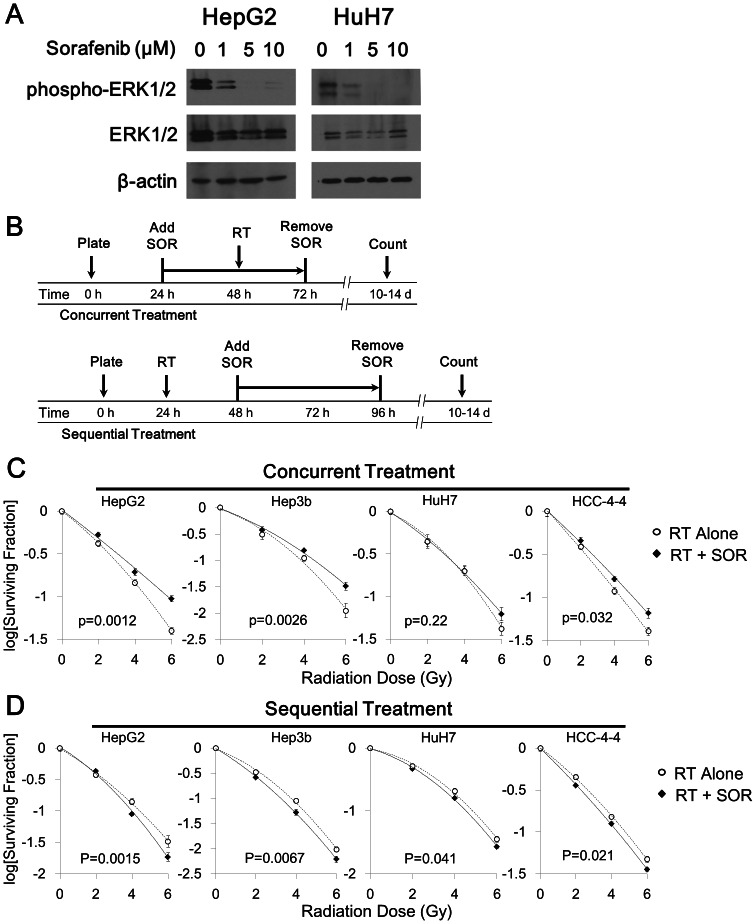
Schedule-dependent effects of combining radiation (RT) and sorafenib (SOR) against HCC cell lines in vitro.(A) Immunoblotting for phospho-ERK showed downregulation after 24 hours of SOR treatment in the HepG2 and HuH7 cell lines in a dose-dependent manner. (B) Schematic diagrams depicting the specific timing of concurrent versus sequential treatment with combined RT-SOR are shown. (C) Concurrent treatment with 5 µM SOR plus RT resulted in radioprotection in 3 of 4 HCC cell lines and had no effect on radiosensitivity in the fourth. (D) Sequential treatment with RT plus 5 µM SOR resulted in decreased colony formation in all 4 HCC cell lines. All best-fit curves are second-degree polynomials derived from the linear-quadratic model and have an R2 value greater than 0.99.